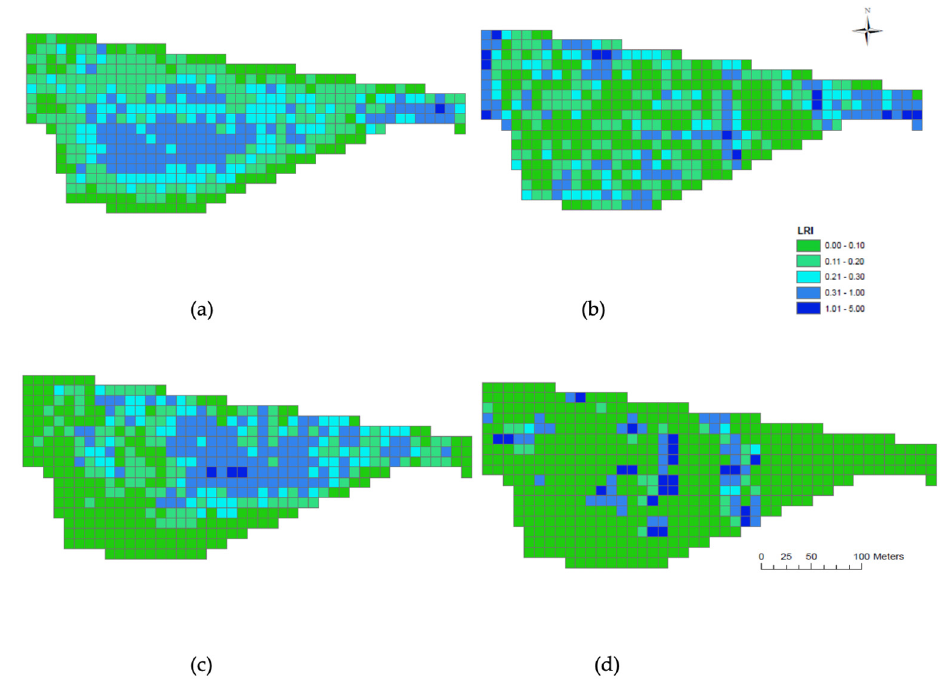
Figure 5. Livestock residency index maps for ewes and alpacas from 22 / 10 / 17 to 31 / 10 / 17. ‘Day’ was considered to be 06:00–19:00 h while ‘Night’ was 20:00–05:00 h. ( a ) ewe day; ( b ) alpacas day; ( c ) ewe night; ( d ) alpacas night. Dark blue grids indicate areas of heaviest stock density residency and green represents areas of lowest stock density residency.